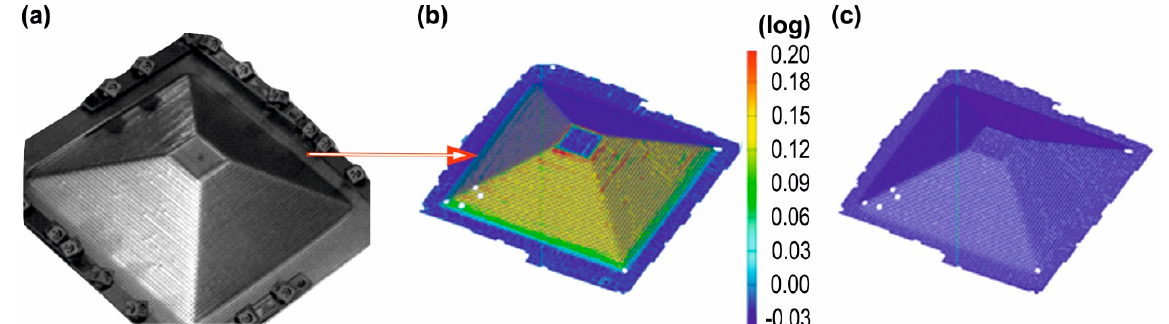
Figure 2. ( a ) Point pattern after incremental forming. ( b ) Major principle strain on the outer surface obtained by ARGUS ® . ( c ) Geometry after forming obtained from ARGUS ® .